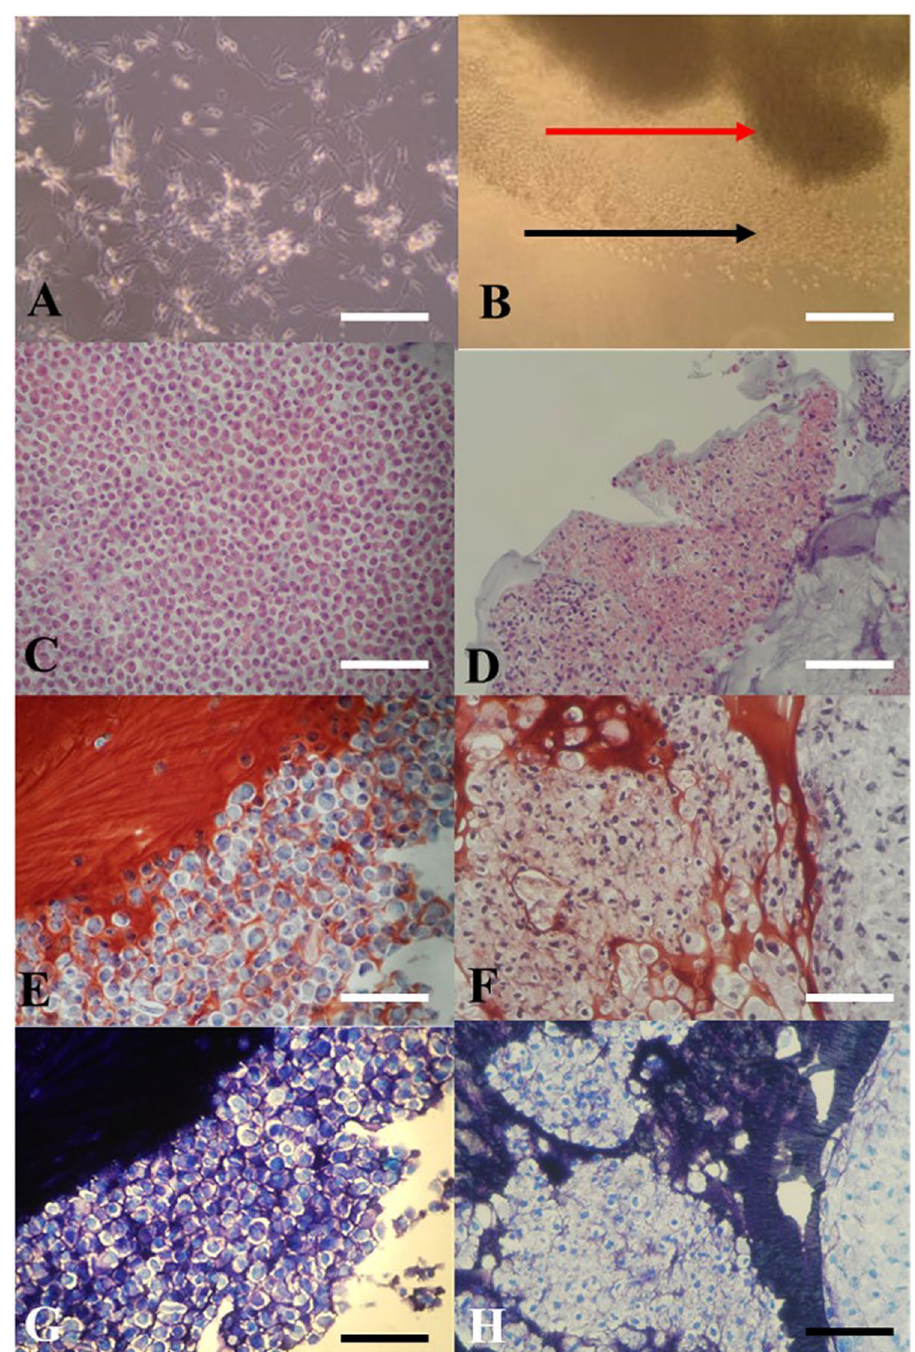
Figure 2. ( A , B ) In vitro culture images: ( A ) Chondrocytes in two-dimensional (2D) culture de-differentiating into fibroblast-like cells; ( B ) In vitro cultured chondrocytes growing in a tissue-like manner in three- dimensional (3D) thermo-reversible gelation polymer (3D-TGP) culture (the red arrow indicates the tissue; the black arrow indicates the cells migrating out into the 3D environment into the tissue); ( C , D ) H-and-E staining images: ( C ) Chondrocytes in 2D observed as individual cells. ( D ) 3D-TGP tissue-engineered chondrocytes exhibiting continuous tissue morphology with hyaline phenotype; ( E , F ) Safranin O/Fast Green staining images: ( E ) Chondrocytes in 2D observed as individual cells. ( F ) 3D-TGP tissue-engineered chondrocytes exhibiting continuous tissue morphology; ( G , H ) Toluidine blue images: ( E ) Chondrocytes in 2D observed as individual cells. ( F ) 3D-TGP tissue-engineered chondrocytes exhibiting continuous tissue morphology (All scale bars = 100